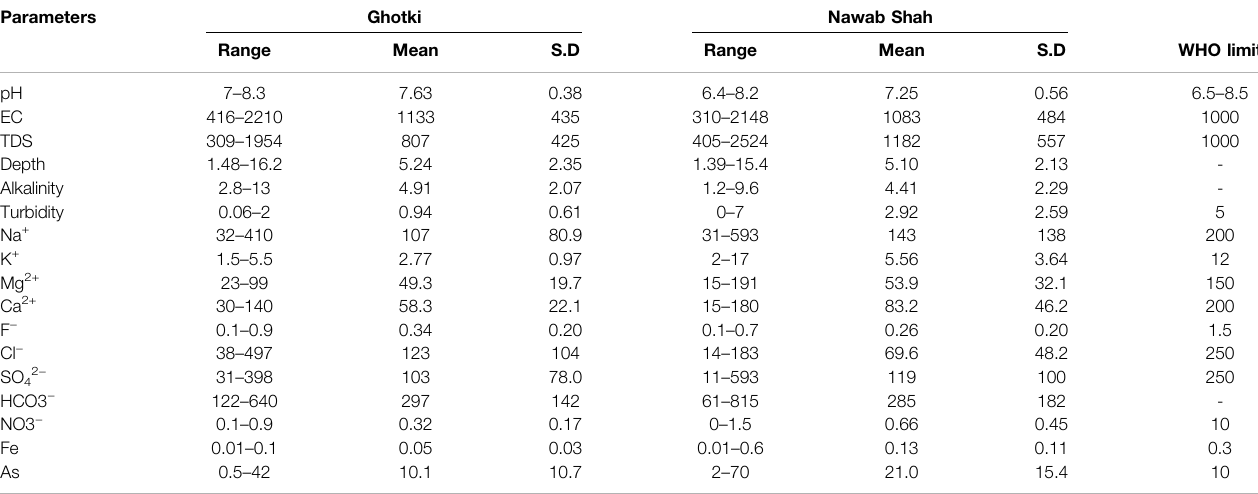
TABLE 1 | Descriptive statistics of groundwater parameters of the Ghotki and Nawab Shah districts. Parameters Ghotki Range